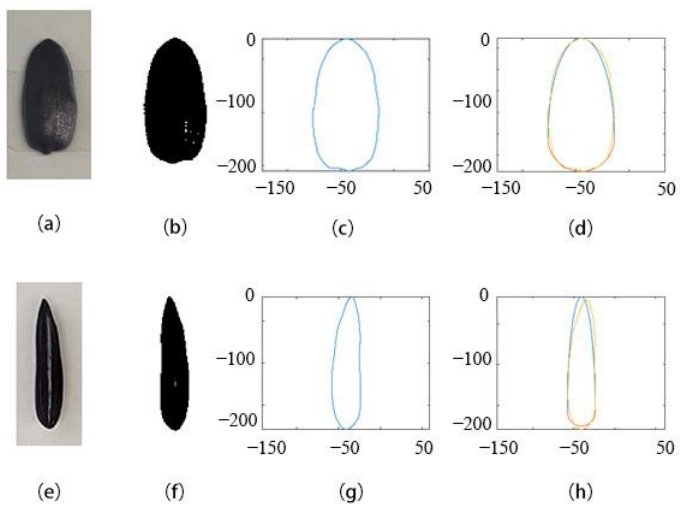
Figure 4. Frequency distribution histogram of seed triaxial measurements. (a). Length distribution; (b). Width distribution; (c). Thickness distribution.